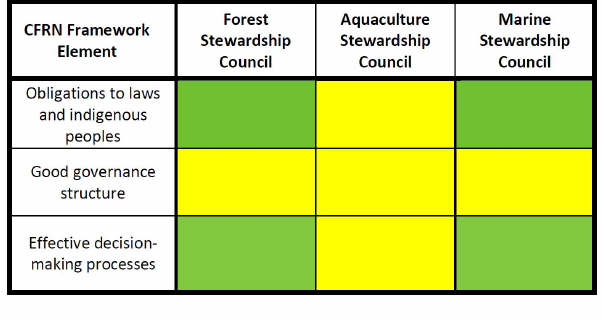
Fig. 2 . Certification criteria of three certification schemes categorized as complete (green), partial (yellow), or no (white) treatment of institutional elements of the Canadian Fisheries Research Network (CFRN) sustainability framework evaluation